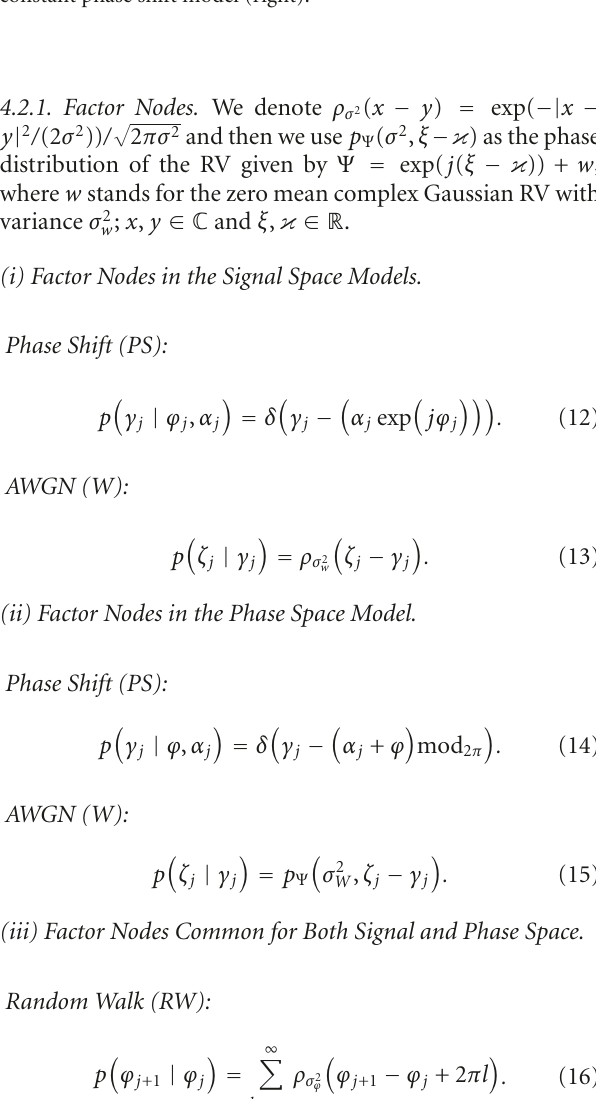
Figure 4: Phase shifts models: random walk model (left) and the constant phase shift model